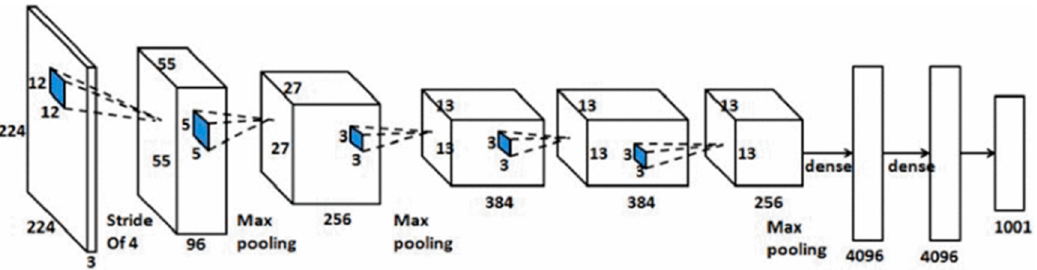
Figure 4. Structure of AlexNet . Table 1. Parameter settings of AlexNet.